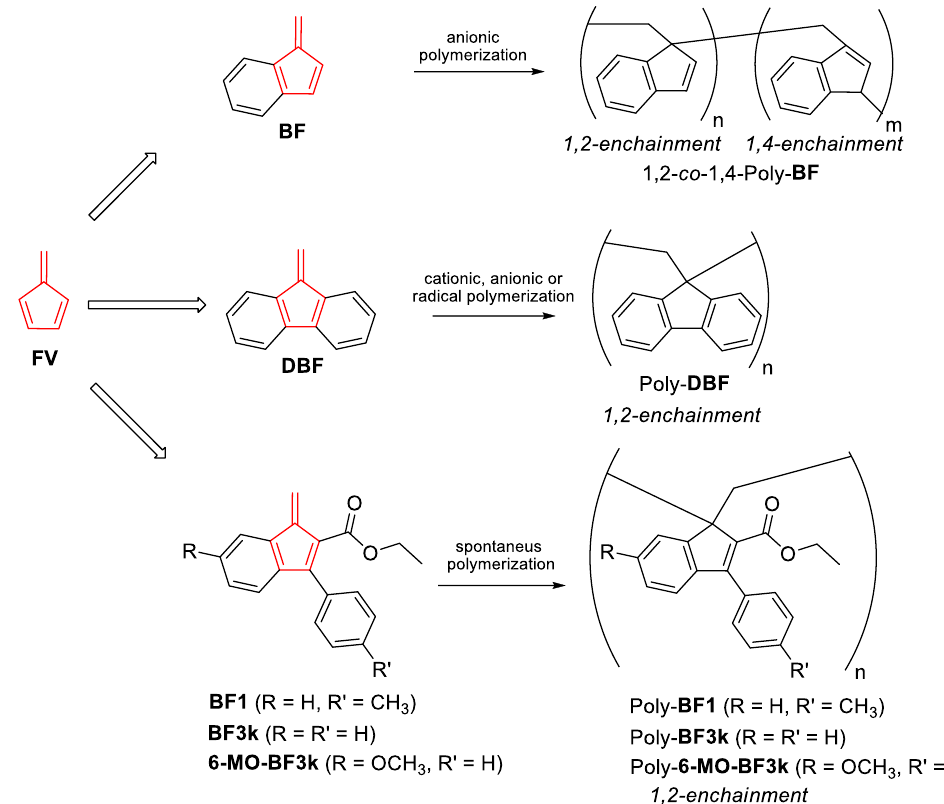
Figure 1. Schematic representation of the most important fulvene monomers and their corresponding